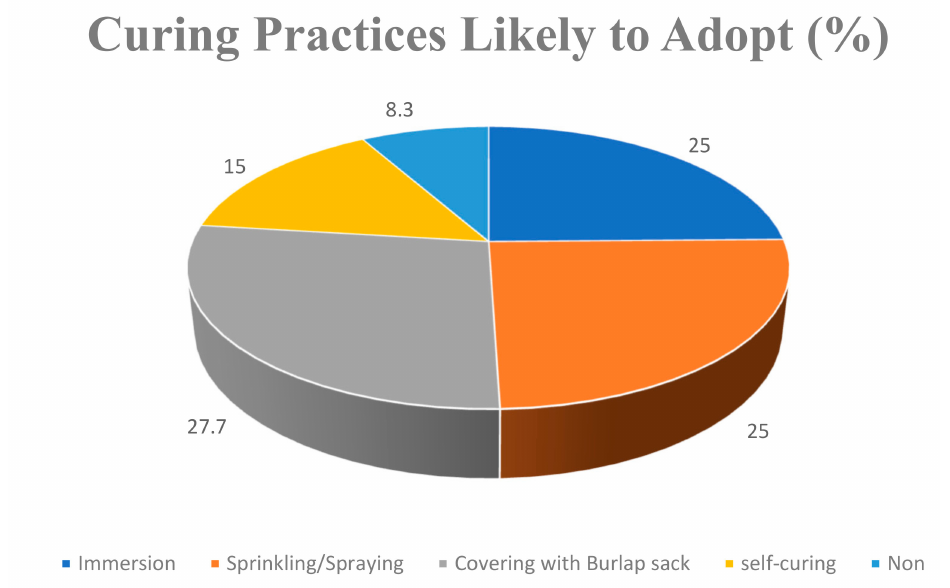
Figure 6. Curing practices likely to adopt in